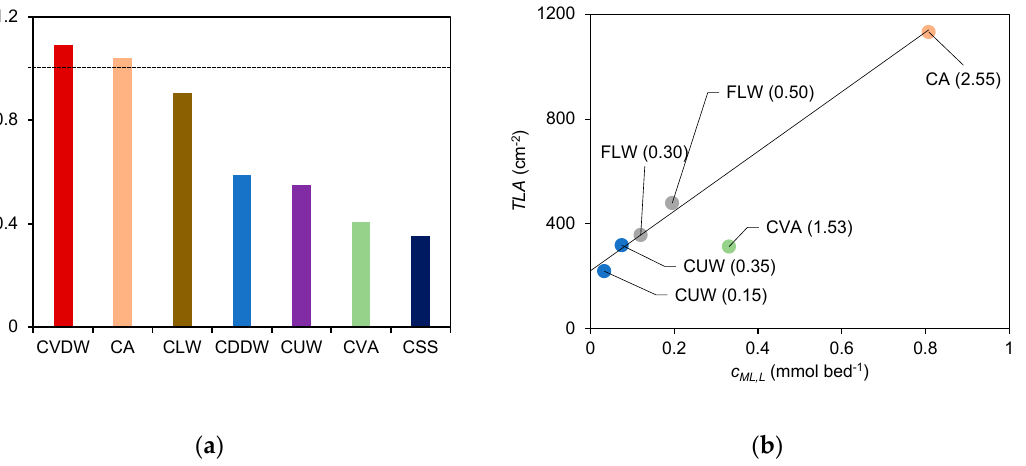
Figure 6. ( a ) Values of the parameter m EF (equivalent mass of FLW). The horizontal line is settled for m EF = 1 kg FLW and ( b ) correlation between the total leaf area ( TLA ) of lettuce from a crop field assay and the parameter c ML,L obtained from metal titrations of the HA extracts.